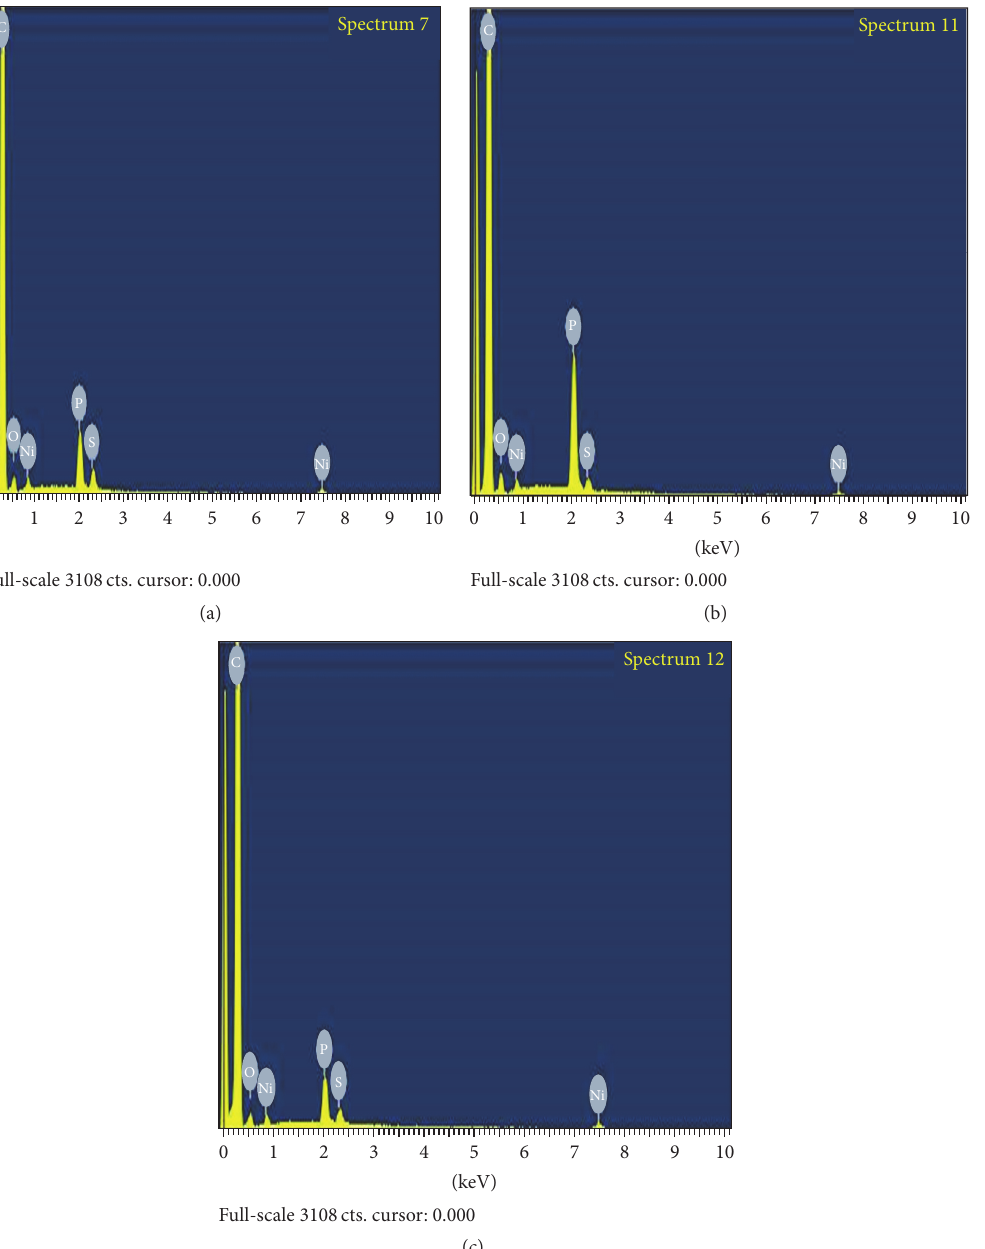
Figure 8: EDS spectra of NiS1 (a), NiS2 (b), and NiS3 (c) of the